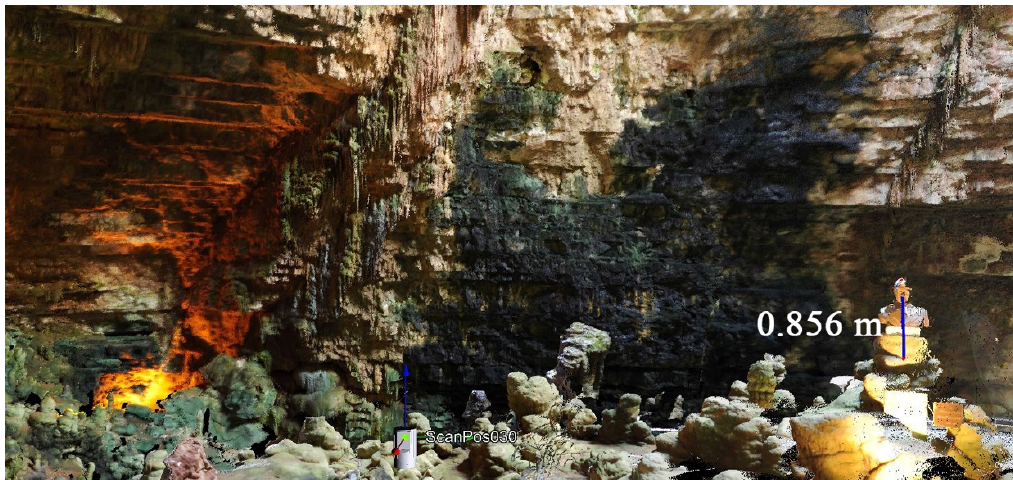
Figure 11. RGB point cloud of the Grave. To the right, height of the bust dedicated to Prof. Franco Anelli (discoverer of the cave system in 1938) provides an indication of scale.